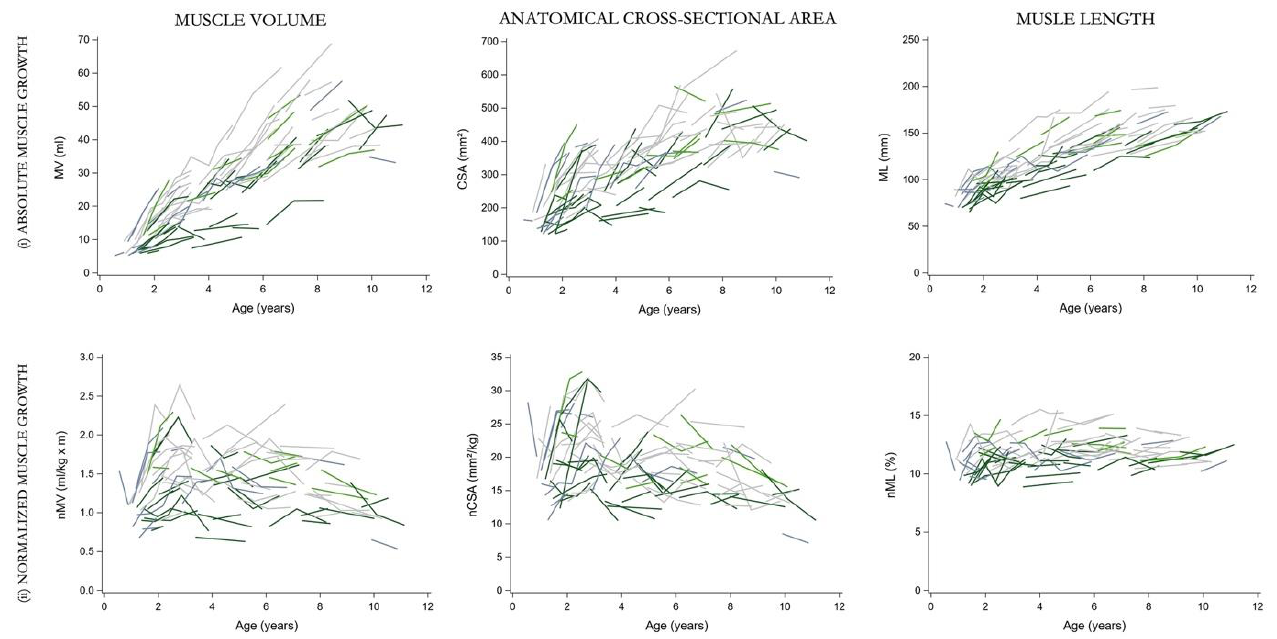
Figure 3. Observed individual trajectories for the ( i ) absolute and ( ii ) normalized muscle morphology for children with unilateral SCP ( n = 51) (grey) and children with bilateral SCP ( n = 36) (green), in GMFCS level I (light colors) and GMFCS level II – III (dark colors) group. GMFCS, gross motor function classification system; SCP, spastic cerebral palsy; n, number; MV, muscle volume; ml, milliliter; CSA, anatomical cross-sectional area; mm, millimeter; ML, muscle belly length; n, normalized.